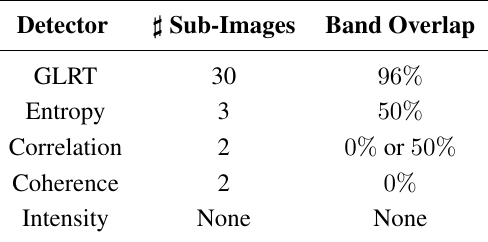
Table 1. Parameters used for sub-look generation. GLRT, generalized likelihood ratio test.